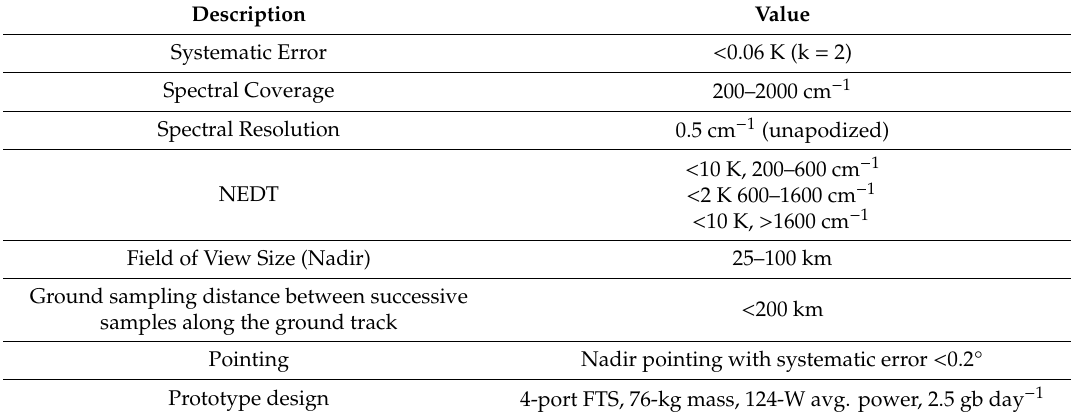
Table 1. The Climate Absolute Radiance and Refractivity observatory (CLARREO) IR spectrometer and Absolute Radiance Interferometer (ARI) requirements, following Wielicki et al.